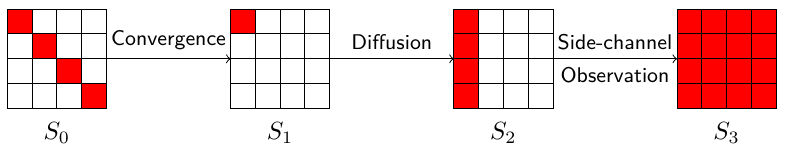
Figure 3: AES differential pattern. Active cells are coloured in